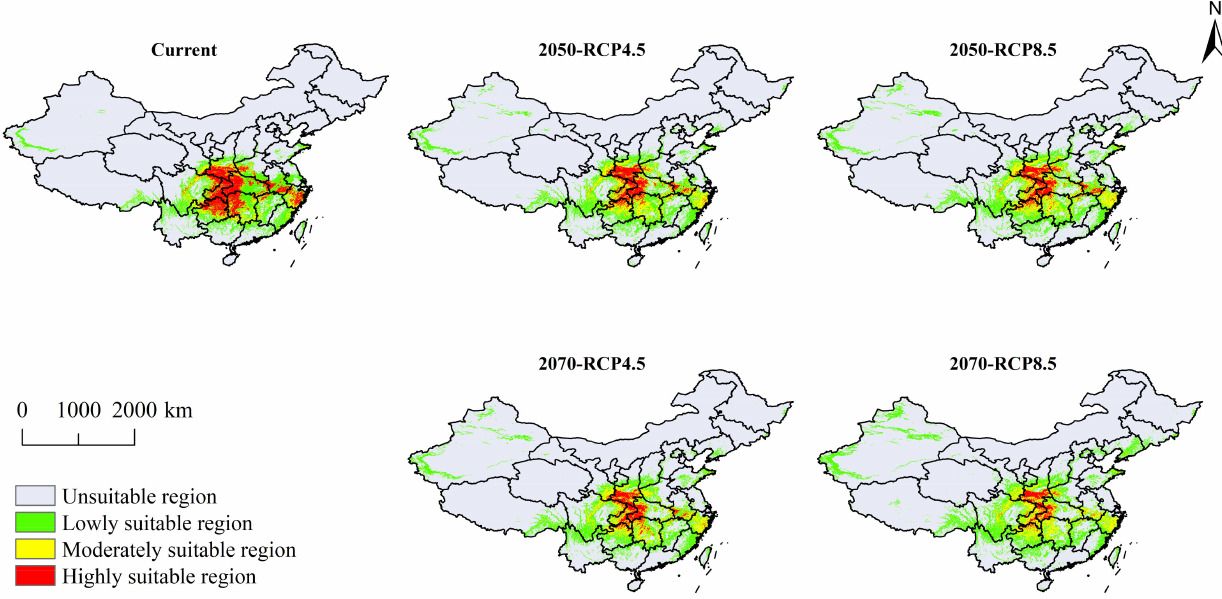
Figure 2. Potentially suitable region of Cypripedium japonicum under current climate and four future climate scenarios: RCP4.5 and RCP8.5 for 2050 and 2070,